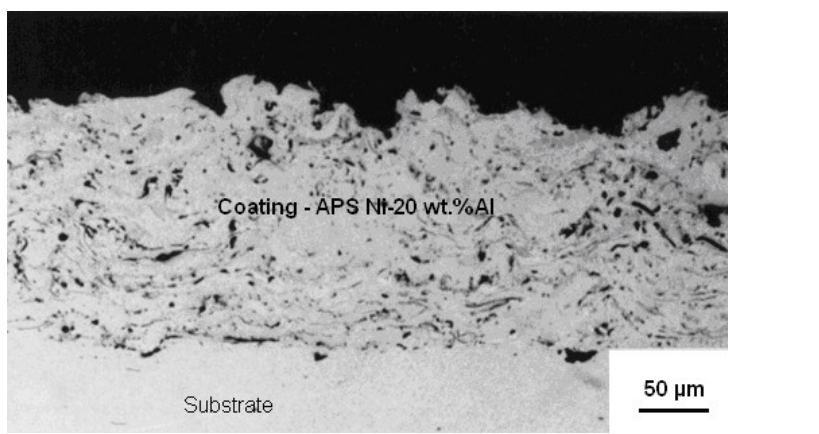
Figure 3 – NI20Al coating microstructure deposited with a (PS) distance of 80